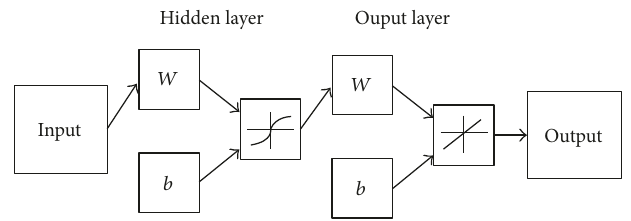
Figure 2: Schematic structure of the ANN model.